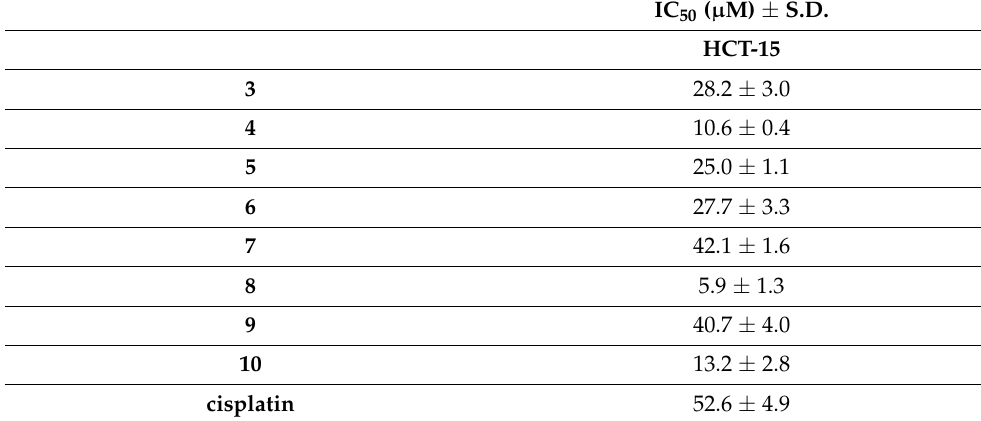
Table 4. Cytotoxicity of complexes 3 – 10 and cisplatin towards colon HCT-15 cancer cell